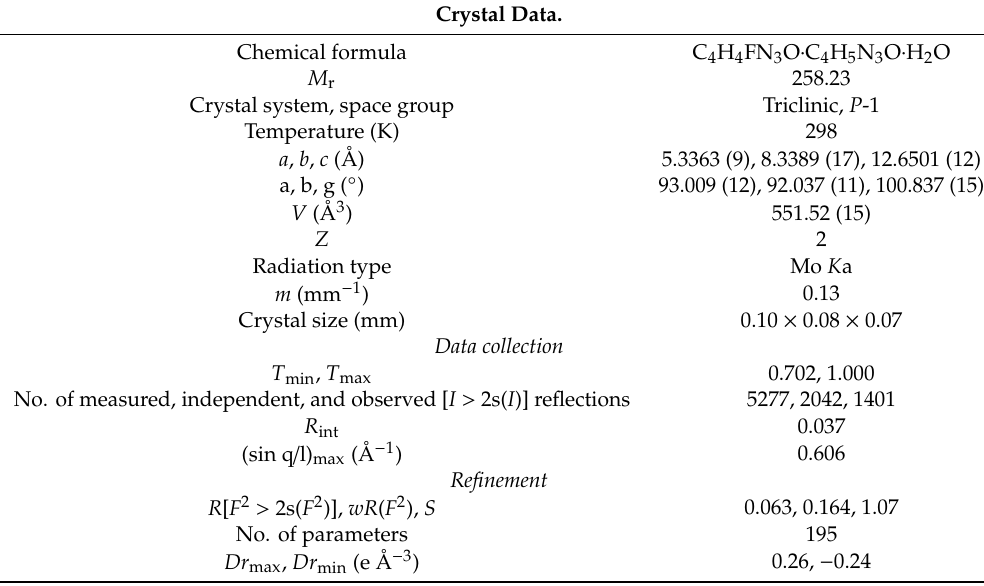
Table 1. Crystal data, data collection, and refinement for compound